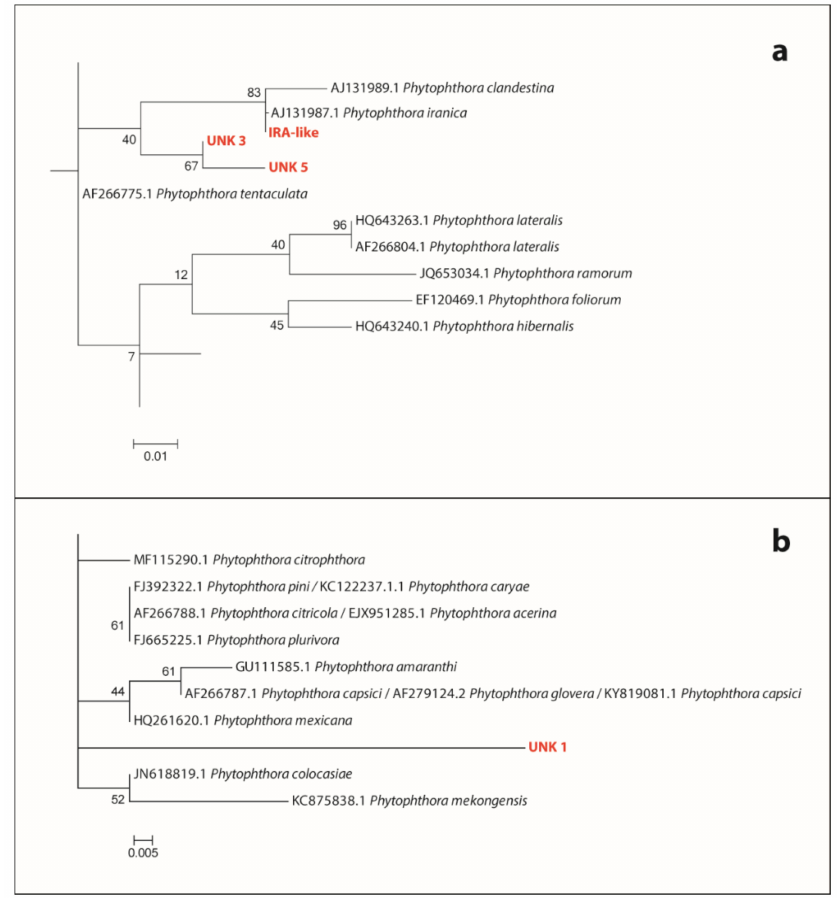
Figure 4. Sections from the phylogenetic tree of the Phytophthora ITS1 locus generated by the Maximum Likelihood method, based on the Tamura-Nei model. ( a ) Position of Phytophthora iranica - like (IRA-like) unknown sp.3 (UNK 3) and sp.5 (UNK 5) within Phytophthora clade 1a; ( b ) Position of Phytophthora unknown sp.1 within Phytophthora clade 2. The bootstrap consensus tree inferred from 1000 replicates is taken to represent the evolutionary history of the taxa analyzed. Branches corresponding to partitions reproduced in less than 50% bootstrap replicates are collapsed. The percentage of replicate trees in which the associated taxa clustered together in the bootstrap test (1000 replicates) is shown next to the